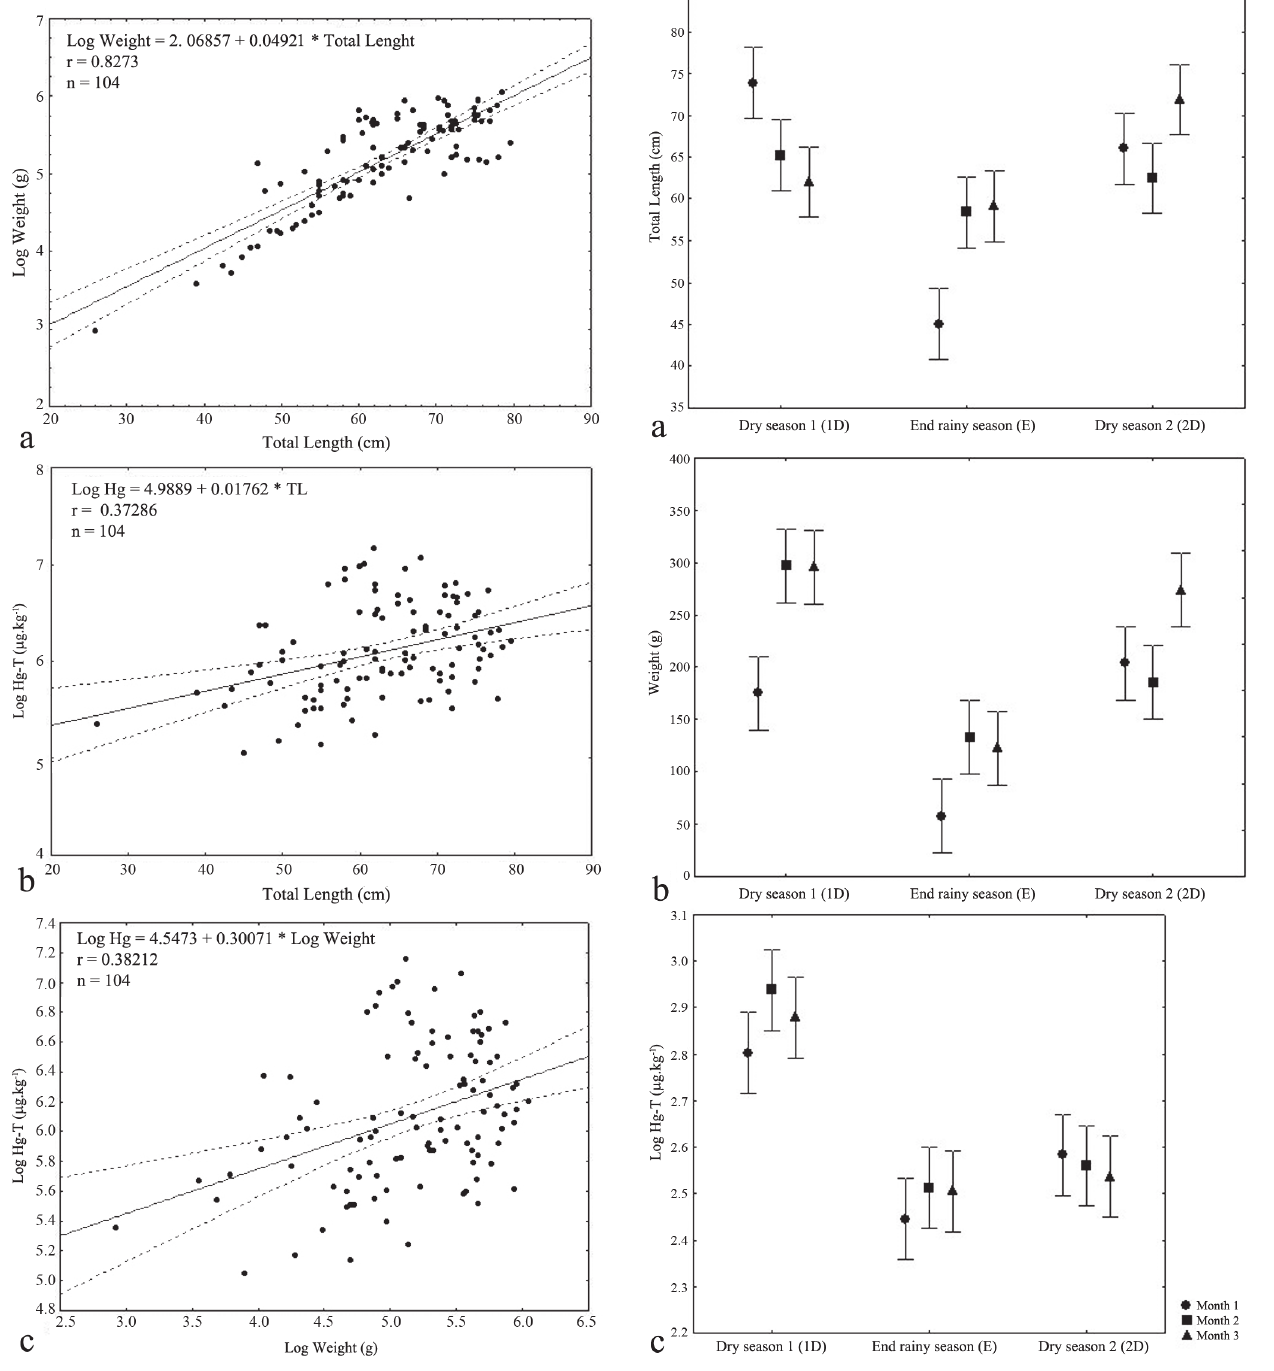
Fig. 3. Correlations (n = 104). a . Log weight (g) in respect to total length (cm); b . Log (mgHg-T.kg -1 in the muscle) in relation to total length (cm); c . Log (mgHg-T.kg-1) in relation to log weight (g) of Trichiurus lepturus from the Goiana Estuary from November 2005 to January 2007. All plots show a 95% confidence interval.